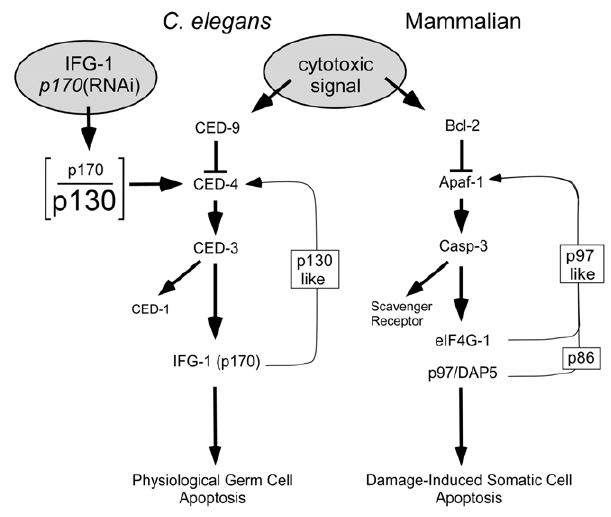
Figure 9. Model for protein synthesis regulation (through eIF4G) of somatic and germ cell apoptosis. In human somatic undergoing apoptosis, eIF4Gs (including p97) are cleaved by caspase-3. The cleavage products support a positive feedback loop that commits the cell to irreversible programmed suicide. This loop is initiated by an insult that disrupts the anti-apoptotic functions of Bcl-2, promoting the formation of apoptosomes from Apaf-1 subunits and sequential activation of a caspase cascade. Caspase-3 causes disruption of the cap-dependent translation initiation complex and further promotes the cap-independent synthesis of Apaf-1 and other apoptotic proteins via internal ribosome entry sites (IRESs) in their mRNAs. In C. elegans germ cells, natural variation or genetic disruption [ p170 (RNAi)] of the cellular balance (depicted as the p170/p130 ratio) between cap-dependent and cap-independent IFG-1 isoforms can initiate apoptosis. Data presented here demonstrate that the caspase cascade is affected upstream (likely at CED-4) by eIF4G cleavage. Additionally, IFG-1 p170 is a direct substrate for CED-3, and processed into a p130-like fragment. Accumulation of the cap-independent fragment may then mimic the function of native p130 to secondarily enhance the synthesis of CED-4 protein. Therefore, a similar positive feedback loop may guide the natural selection of oocytes for apoptosis as a function of their translational